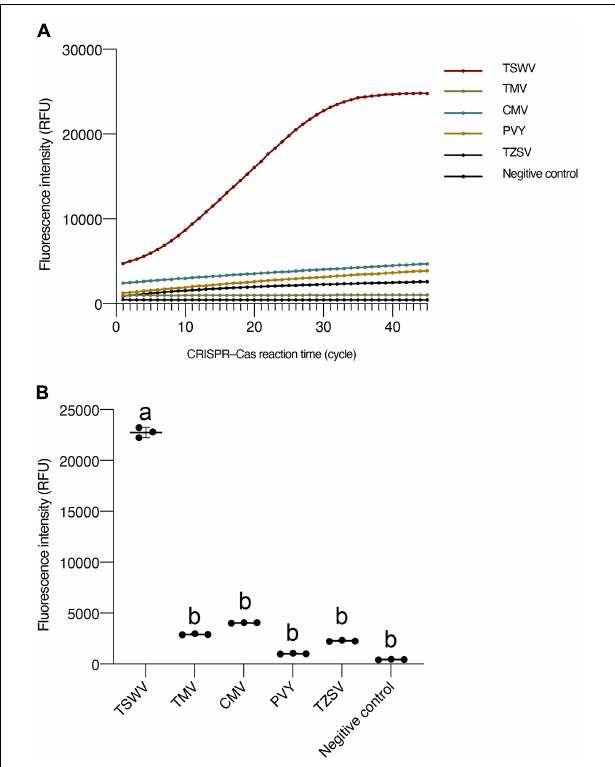
FIGURE 3 | The sensitivity of CRISPR/Cas13a-based detection. (A) Fluorescence intensity for plasmid templates of RPA reactions with different concentrations. (B) Intensity of fluorescence signals generated after 15 min (30 kinetics cycles) of CRISPR/Cas13a-based detection at each dilution. The negative control has RNase-free water as an input instead of RPA production. Data are the mean ± SD from triplicate biological replicates measurements. Comparisons between the groups were made using an analysis of variance (ANOVA) followed by a Tukey’s test. Different letters above the error bars indicate significant differences at the 0.05 level. RPA, recombinant polymerase amplification; SD, standard deviation.